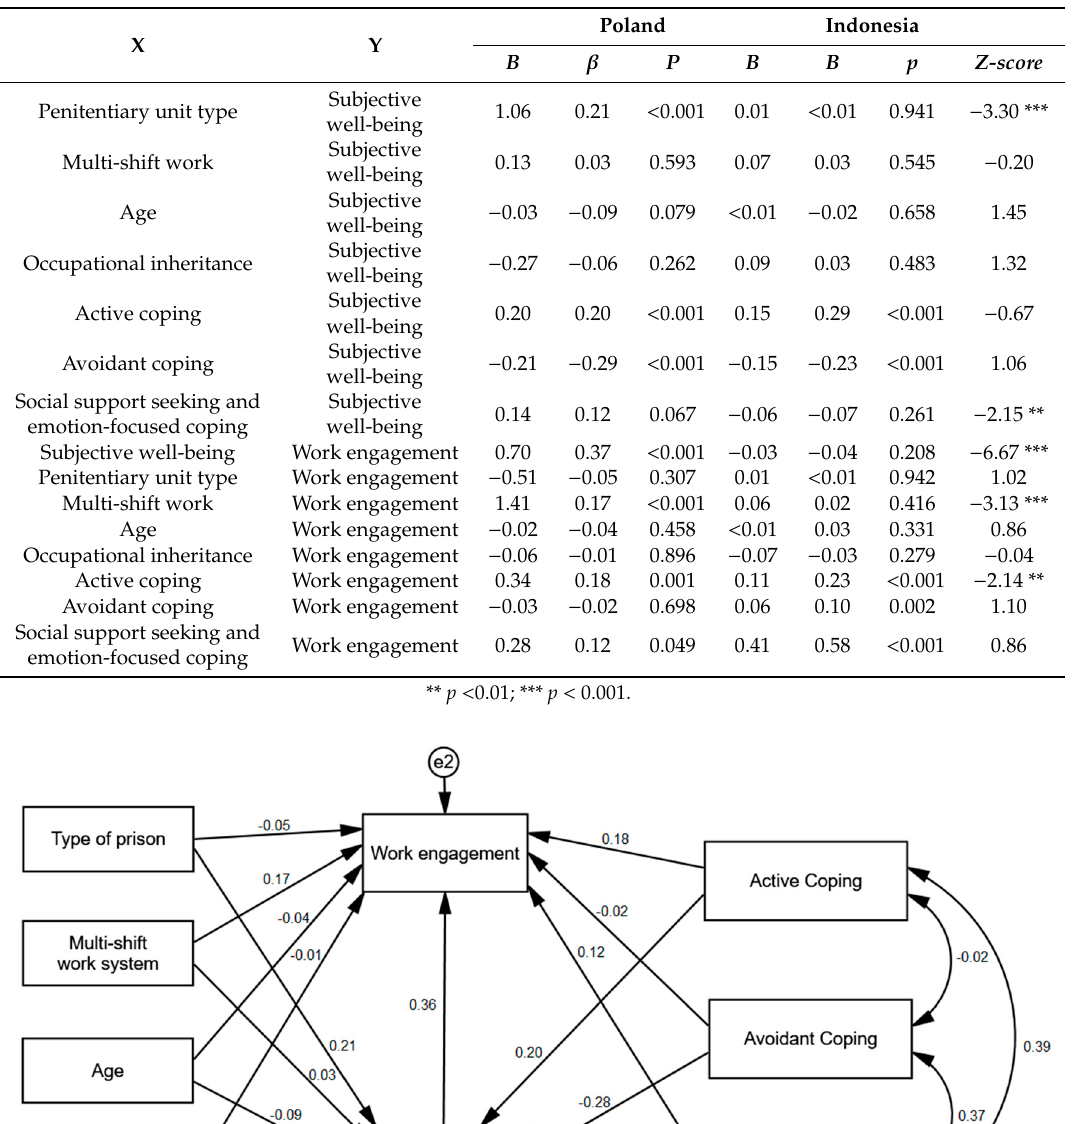
Table 4. Comparison of standardized regression coe ffi cients for the paths in the model for Polish and for Indonesian POs.